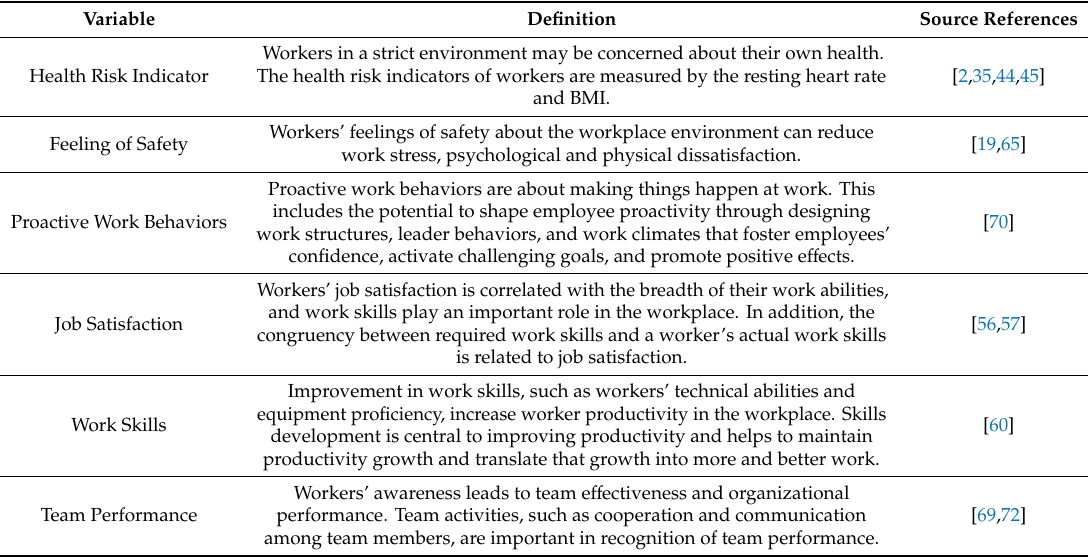
Figure 2. Hypothetical structural model for construction workers’ perceptions. Table 2. The definition of the variables used in this study.